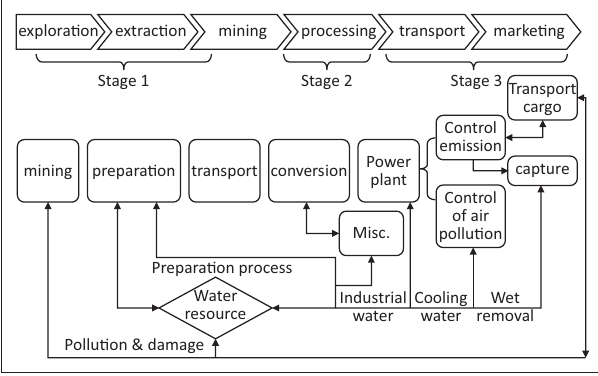
FIGURE 1: Mining value